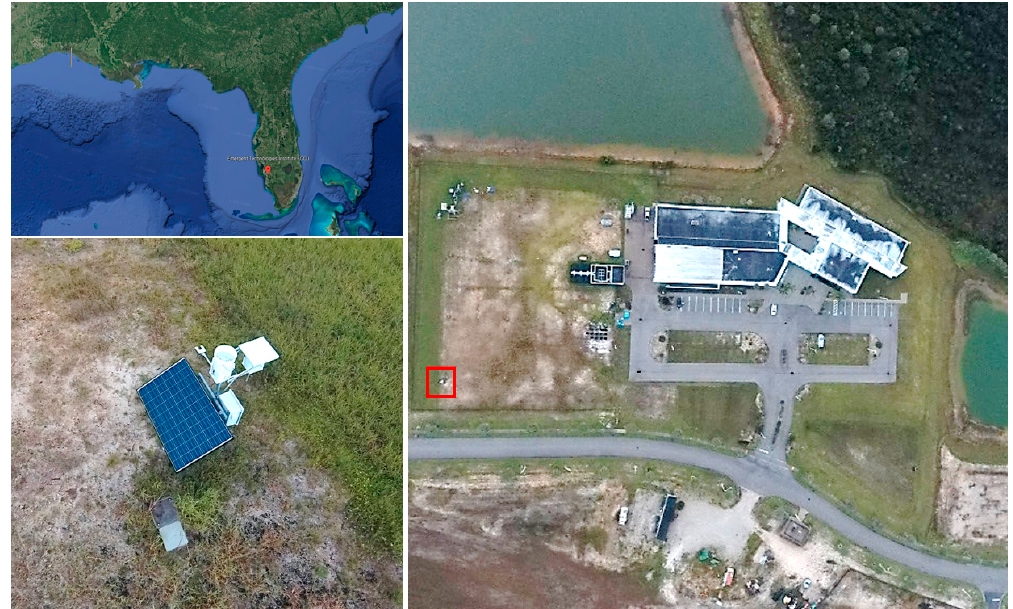
Figure 2. Map showing the location of the sample collection station. A close-up of the dry and wet sampling device is shown in Figure 3.